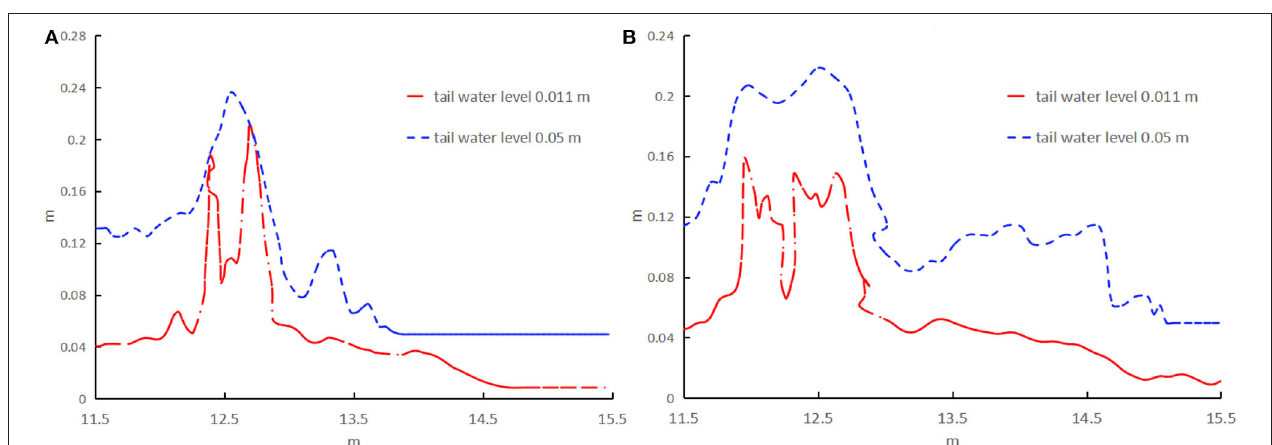
FIGURE 8 | The free surface profile at different times: (A) t